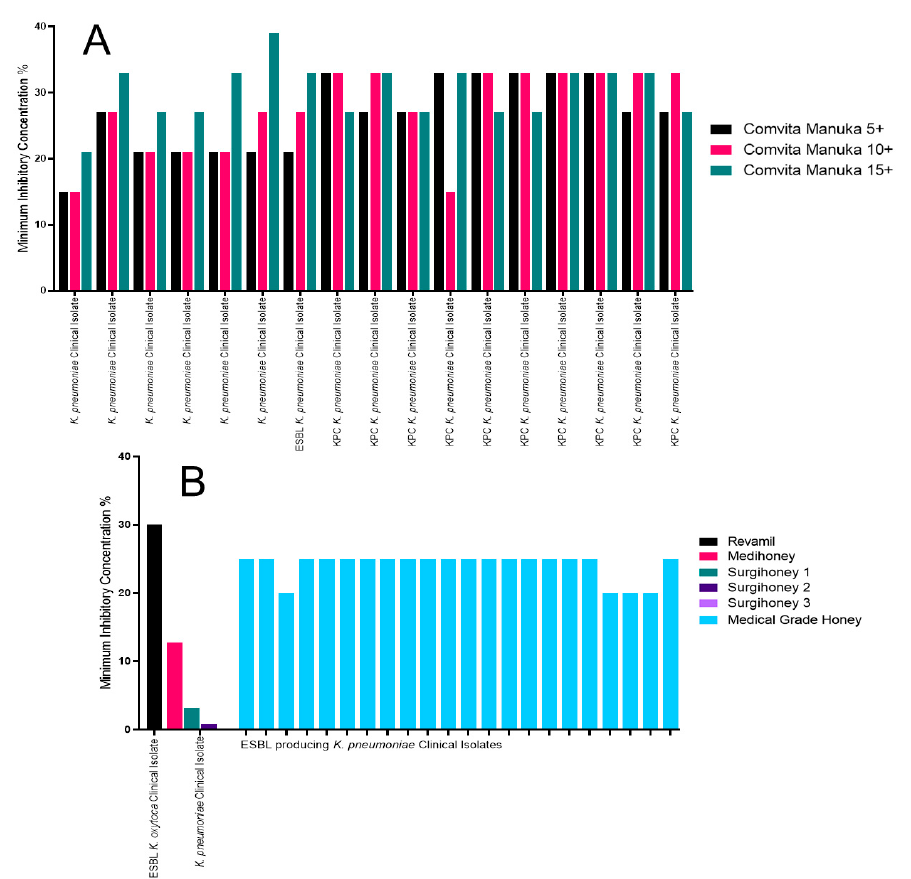
Figure 4. MICs of the K. pneumoniae isolates tested against a variety of Manuka and